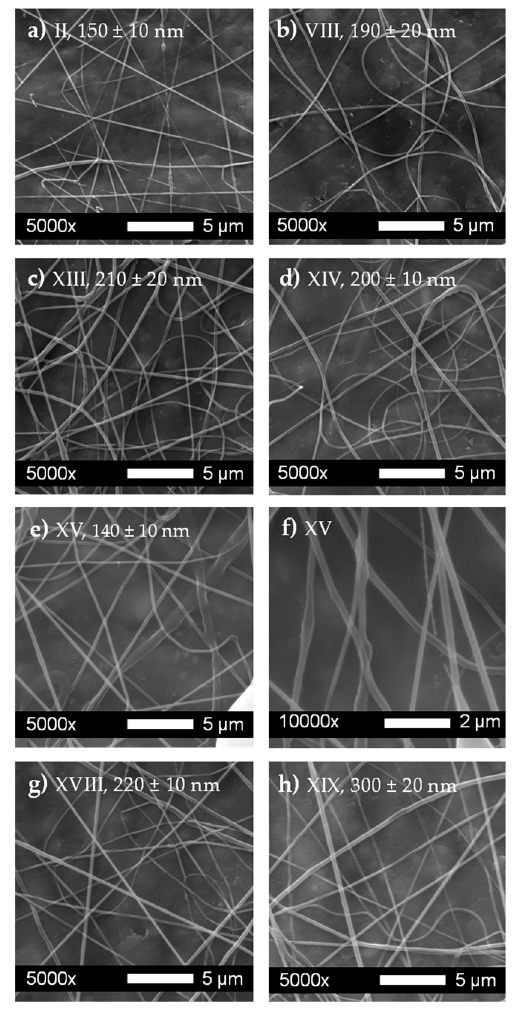
Figure 2. Scanning electron microscopy (SEM) images of electrospun PCL fibers and their average diameters corresponding to different runs of Table 2: ( a ) Run II, ( b ) Run VIII, ( c ) Run XIII, ( d ) Run XIV, ( e ) Run XV, ( g ) Run XVIII and ( h ) Run XIX. The image ( f ) corresponds to Run XV at a higher magnification of 10,000×.